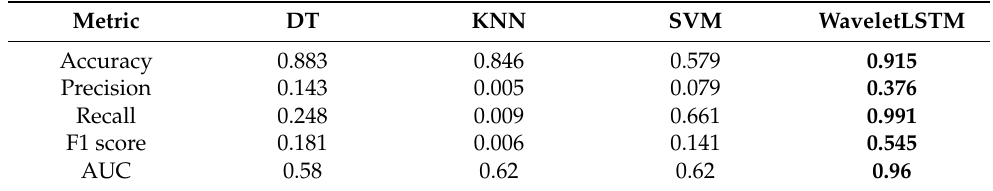
Table 5. Comparison of results with shallow machine learning methods in terms of classification